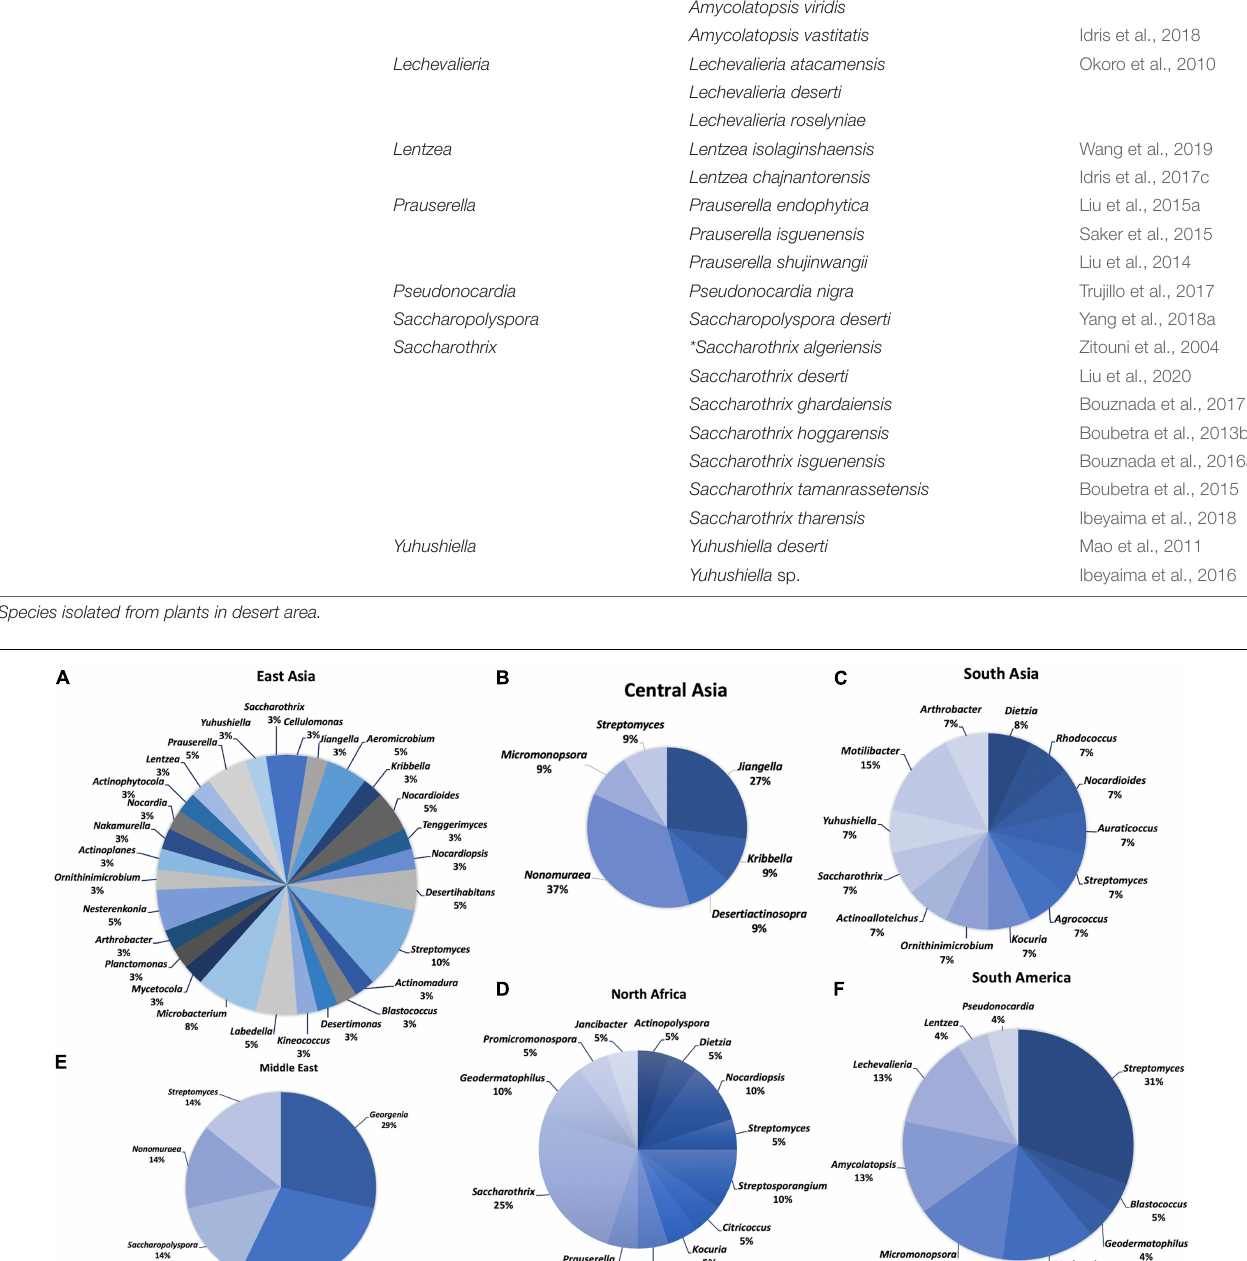
(2%), Thermomonosporaceae (2%),